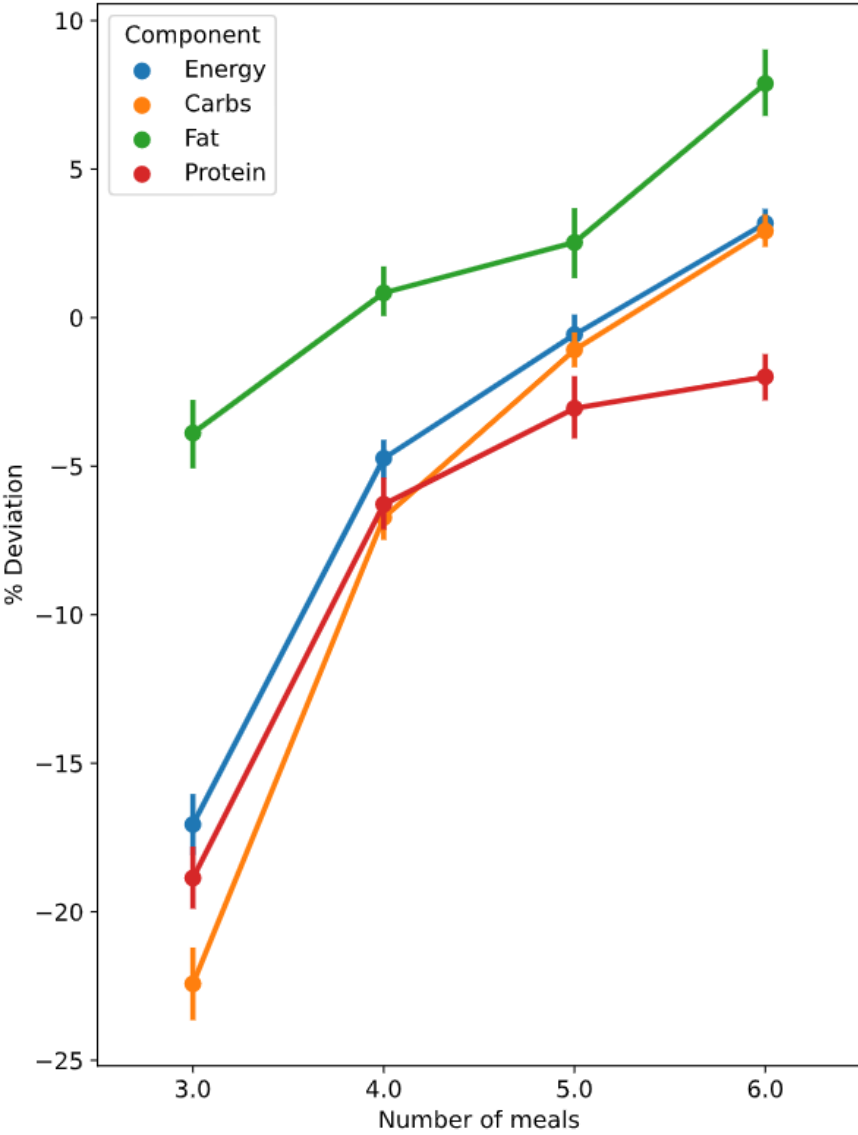
Figure 3. Error plot representing the daily percentual deviations of energy and macronutrients between needs and planned meals (Components) for each selected number of